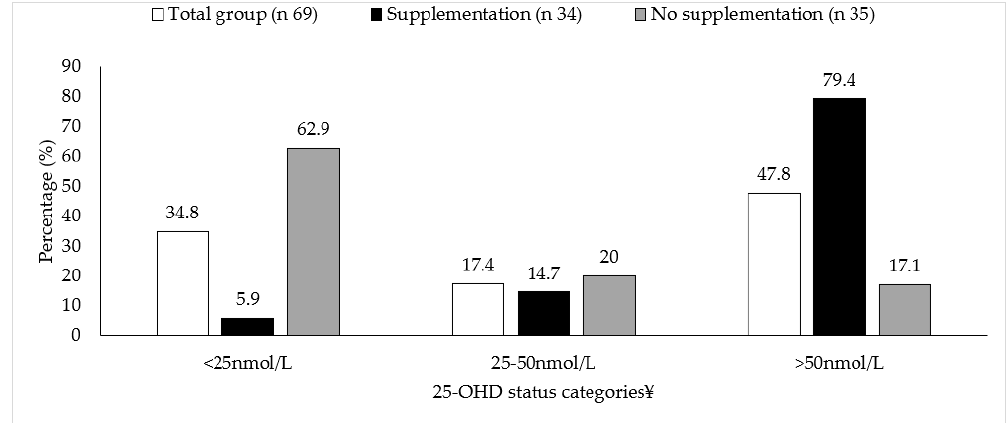
Figure 3. Vitamin D ± calcium supplement use by category of plasma 25-OHD concentration. ¥ Cat- egories for 25-OHD concentration: deficient (<25 nmol/L), insufficient (25-50 nmol/L), sufficient (>50 nmol/L).